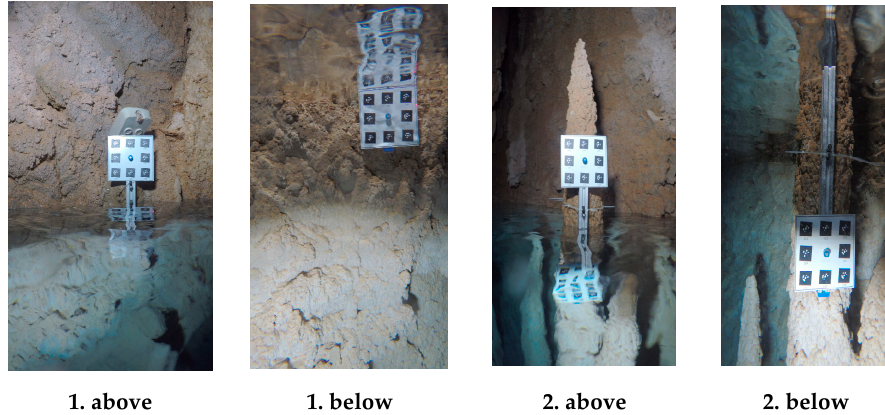
Figure 18. Example of synchronized images taken with the stereo rig across the water, i.e., a camera looking below the water surface and another above the water. The images show two calibrated rigs installed for accuracy assessment evaluations.